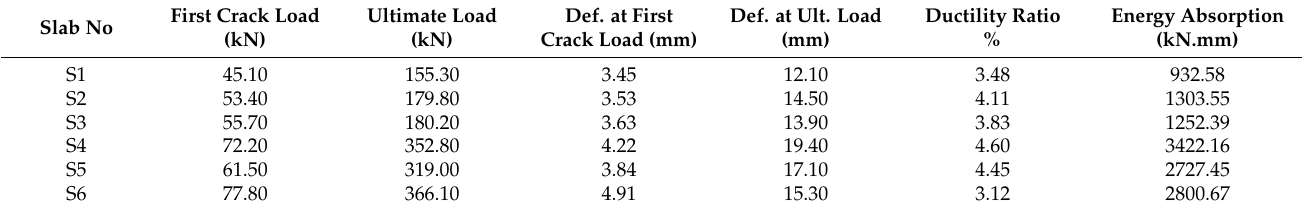
Table 11. Experimental